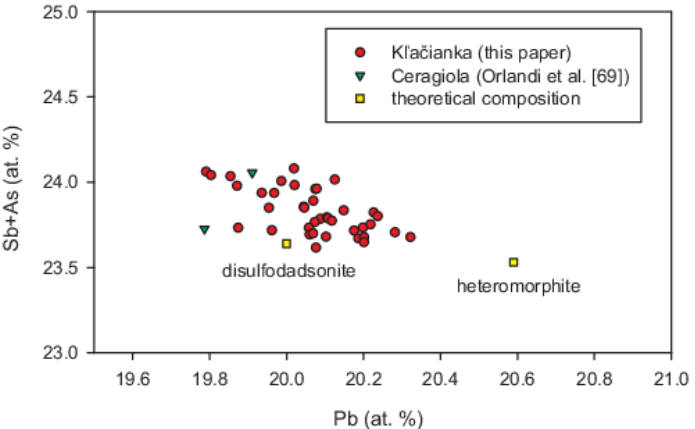
Figure 8. Chemical composition of disulfodadsonite in the graph Pb vs. Sb + As (at.%); theoretical composition: disulfodadsonite Pb 11 Sb 13 S 30 S; heteromorphite Pb 7 Sb 8 S 19 .